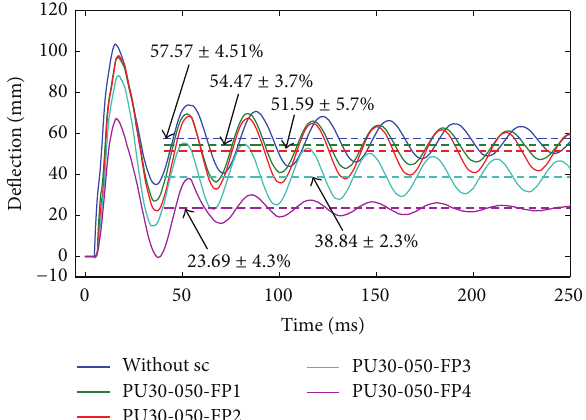
Figure 16: The effect of the front plate mass on the absorption